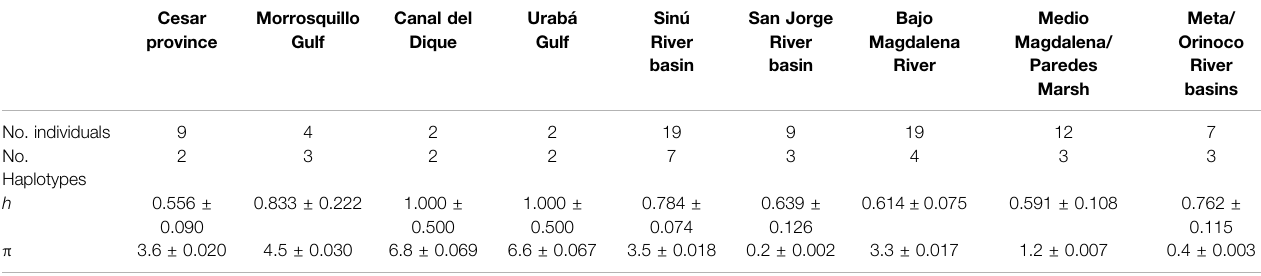
TABLE 3 | Genetic diversity statistics for T. manatus from Colombian sampling locations. Haplotype diversity ( h ) and nucleotide ( π ) diversity (in %) are shown for each geographic location ( ± SD). The Santa Marta location was excluded due to small sample size ( n (cid:1) 1).